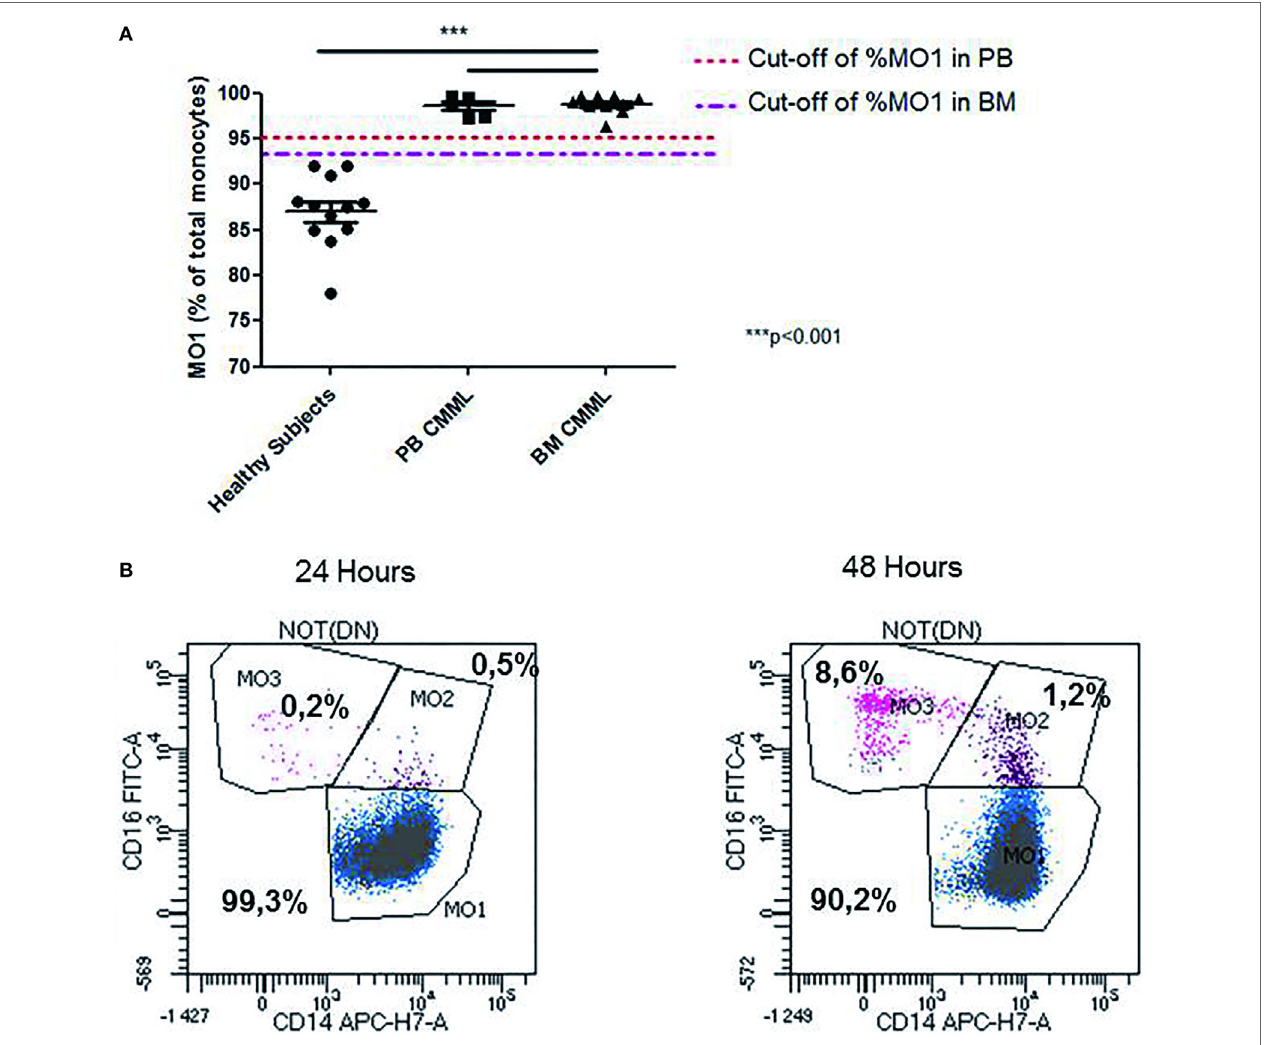
FigUre 3 | Abnormal repartition of monocyte subsets in chronic myelomonocytic leukemia (CMML). Evaluation of the MO1 percentage cut-off subset in peripheral blood (PB) ( n = 5) and bone marrow (BM) ( n = 10) in the CMML group (a) . The MO1 percentage cut-off points were compared with the threshold set (1 × 10 9 /L) for the PB monocytosis. The differences between the values obtained in the MO1 percentage in BM and PB for the CMML group compared with those detected in the healthy subjects were statistically significant (*** p < 0.001; Fisher test). Representative example for the differences observed in the distribution of monocytes subset when the test was performed at 24 and 48 h after sample harvesting. The monocytes subsets are expressed as a percentage of total monocytes (B)